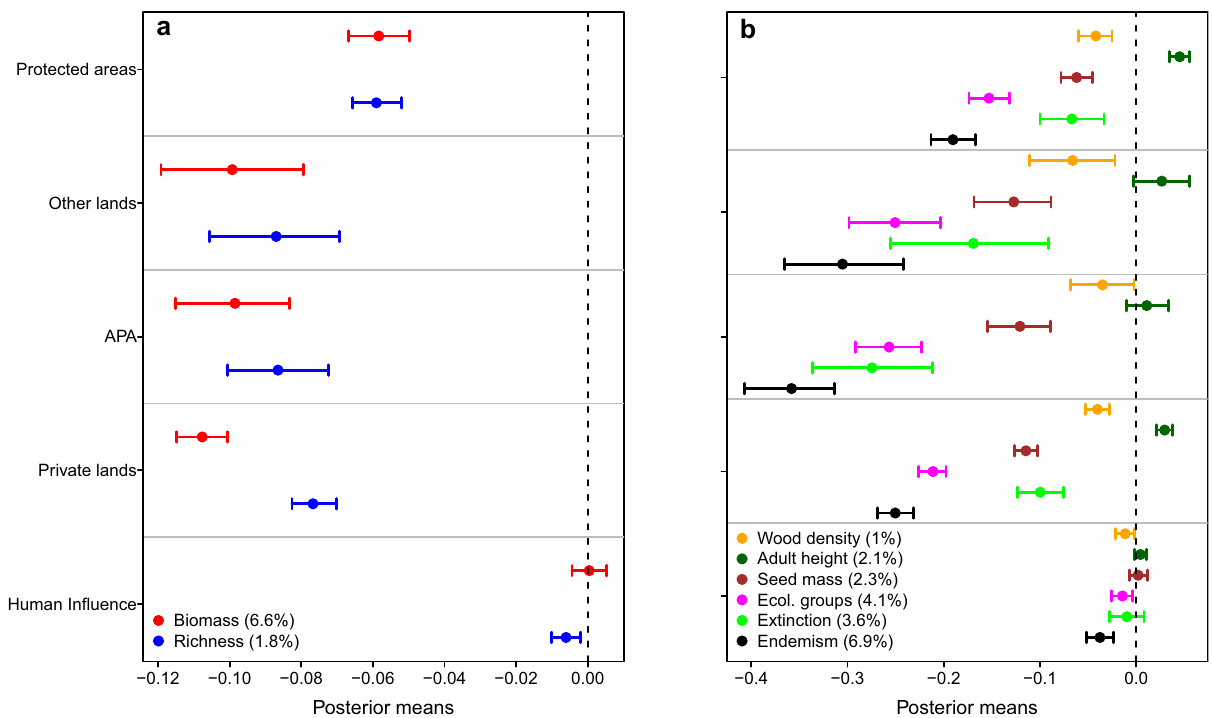
Fig. 6 The effect of land conservation category and of the Human In fl uence Index on the carbon and biodiversity losses in the Atlantic Forest. Each point represents the posterior mean of the standardized effect sizes of the multivariate regression models containing the joint losses of a forest biomass and species richness ( n = 1647 surveys) and b of community-weighted means of species properties ( n = 1213 surveys). For the categorical variable ‘ land conservation ’ , posterior means refer to the estimates of the model intercept, while for the continuous variable ‘ human in fl uence ’ the means are the estimates of the model slope. The error bars (i.e. 95% credibility intervals) touching the dashed line re fl ect the lack of support of a signi fi cant effect of the covariables. The coef fi cient of correlation of each model ( R 2 ) is reported in parentheses. Legend: Protected areas indicate Strict protection and Sustainable use conservation units; Other lands indicate research centres, university campuses, botanical gardens, and military and indigenous lands; APA indicate private lands inside areas with sustainable use of natural resources, locally known as “ Environmental Protection Areas ” (APA is the acronym in Portuguese). Table 3 The average loss of forest carbon and its projection to the remaining Atlantic Forest